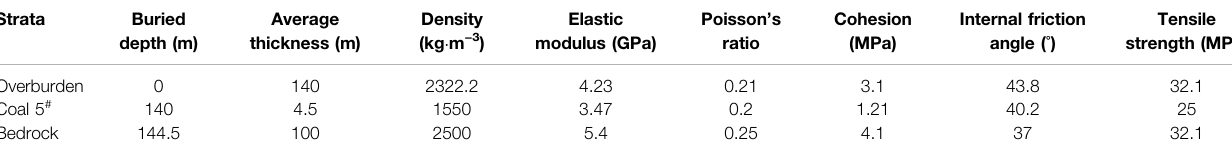
TABLE 12 | Buried depth, physical and mechanical parameters of coal seams, and strata in the West Bokaro open-pit mine.\ Strata Buried depth (m)